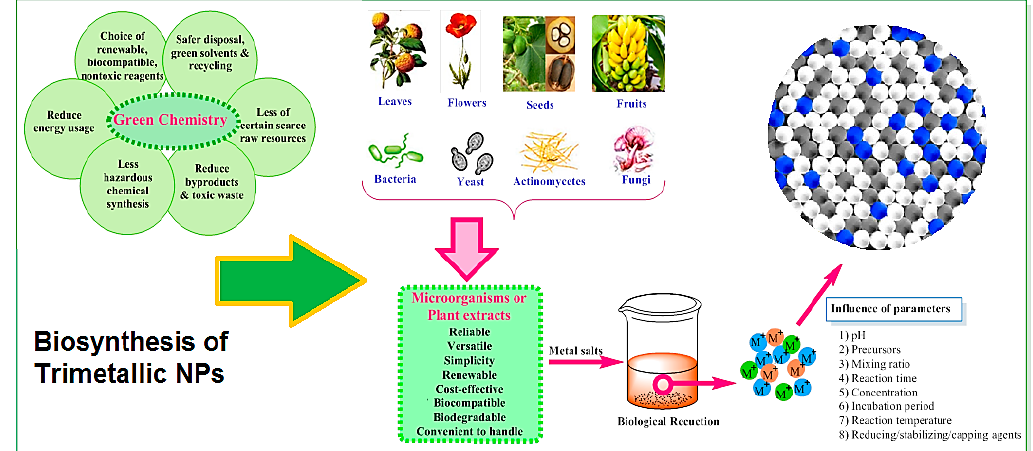
Figure 3. Bio ‐ based synthesis of trimetallic NPs and their important advantages and